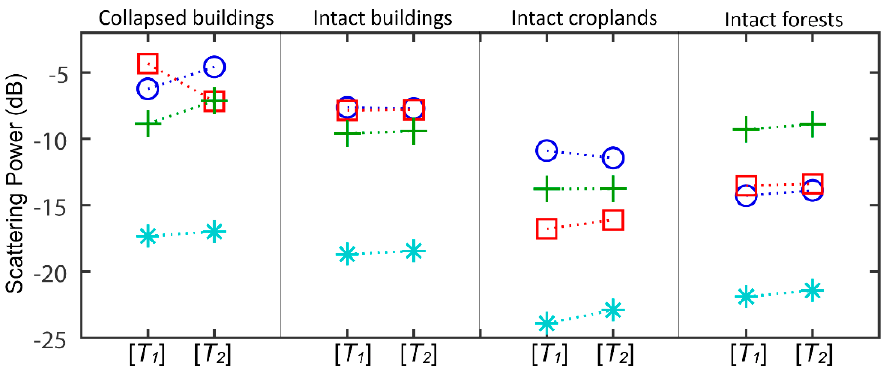
Figure 6. The surface (blue-circle symbol), double-bounce (red-square symbol), volume (green-cross symbol), and helix (cyan-star symbol) scattering contributions of the scattering power decomposition for the selected regions of interest.